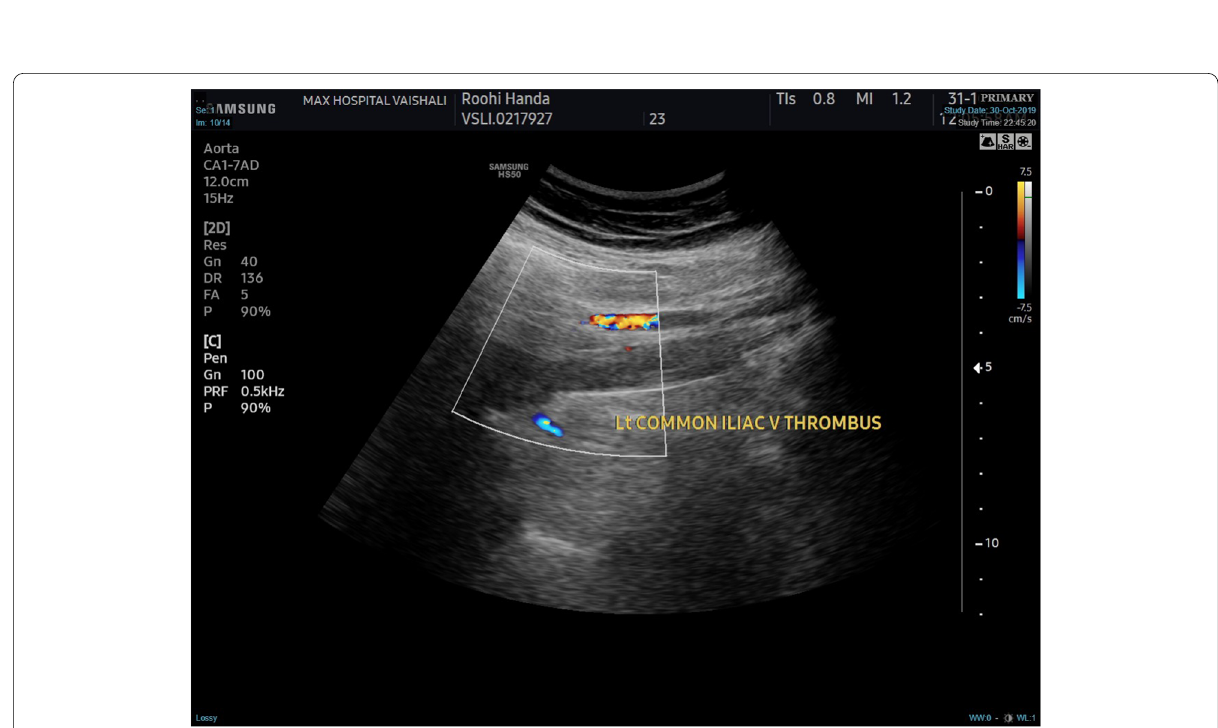
Fig. 6 Venous Doppler of lower limb revealed deep vein thrombosis involving left common and external